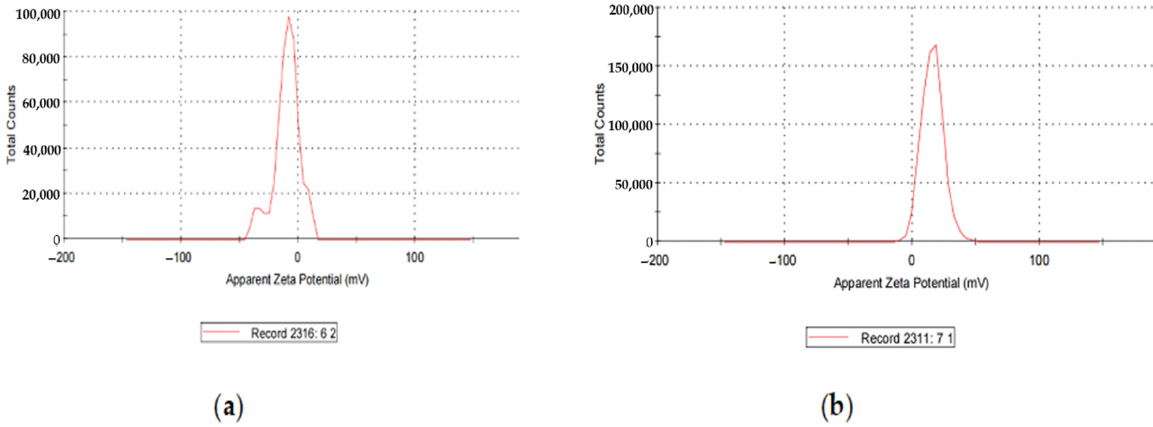
Figure 4. ( a ) Zeta Potential of AgNPs; ( b ) zeta Potential of CIP-AgNPs.